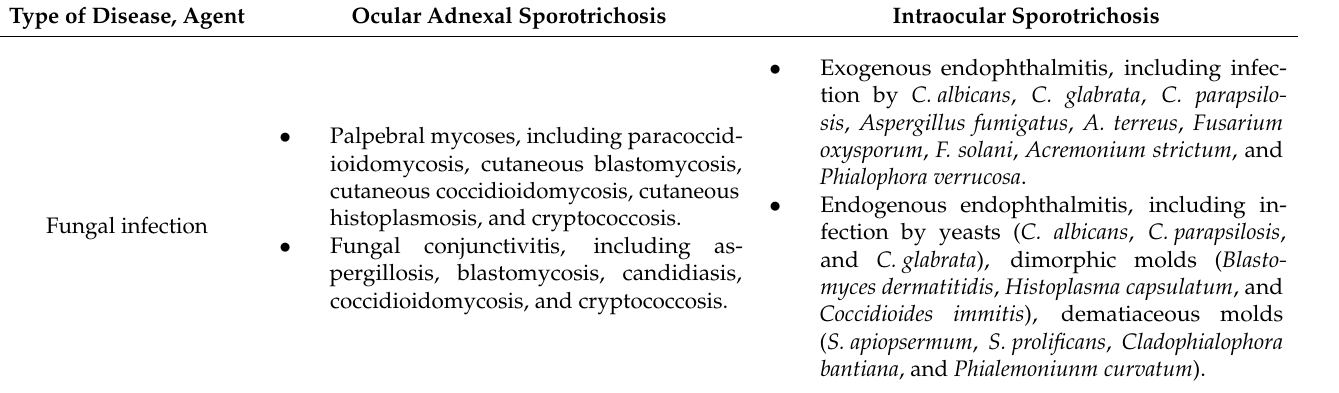
Table 6. Primary differential diagnoses of ocular